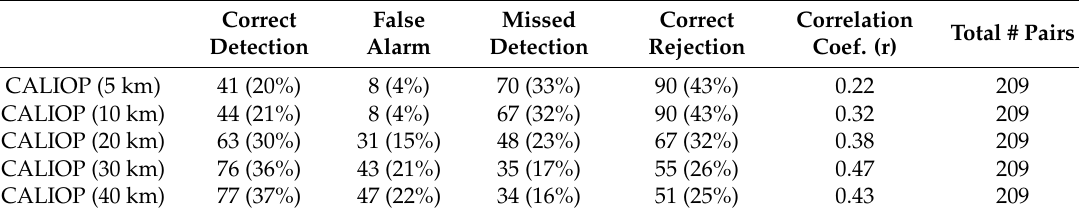
Table 5. Contingency tables and correlation coefficients (r) of ceilometer CBHs at KRHP and nighttime satellite retrieved CBHs using different horizontal averaging scales (5-, 10-, 20-, 30-, and 40-km) of CALIOP Level 2 cloud layer product (333-m CBHs). Values in parentheses are expressed as a percentage of the total number of observation pairs (last column of the table). Note the 20-min window centered over the satellite overpass time is applied to obtain the matched ceilometer CBHs at